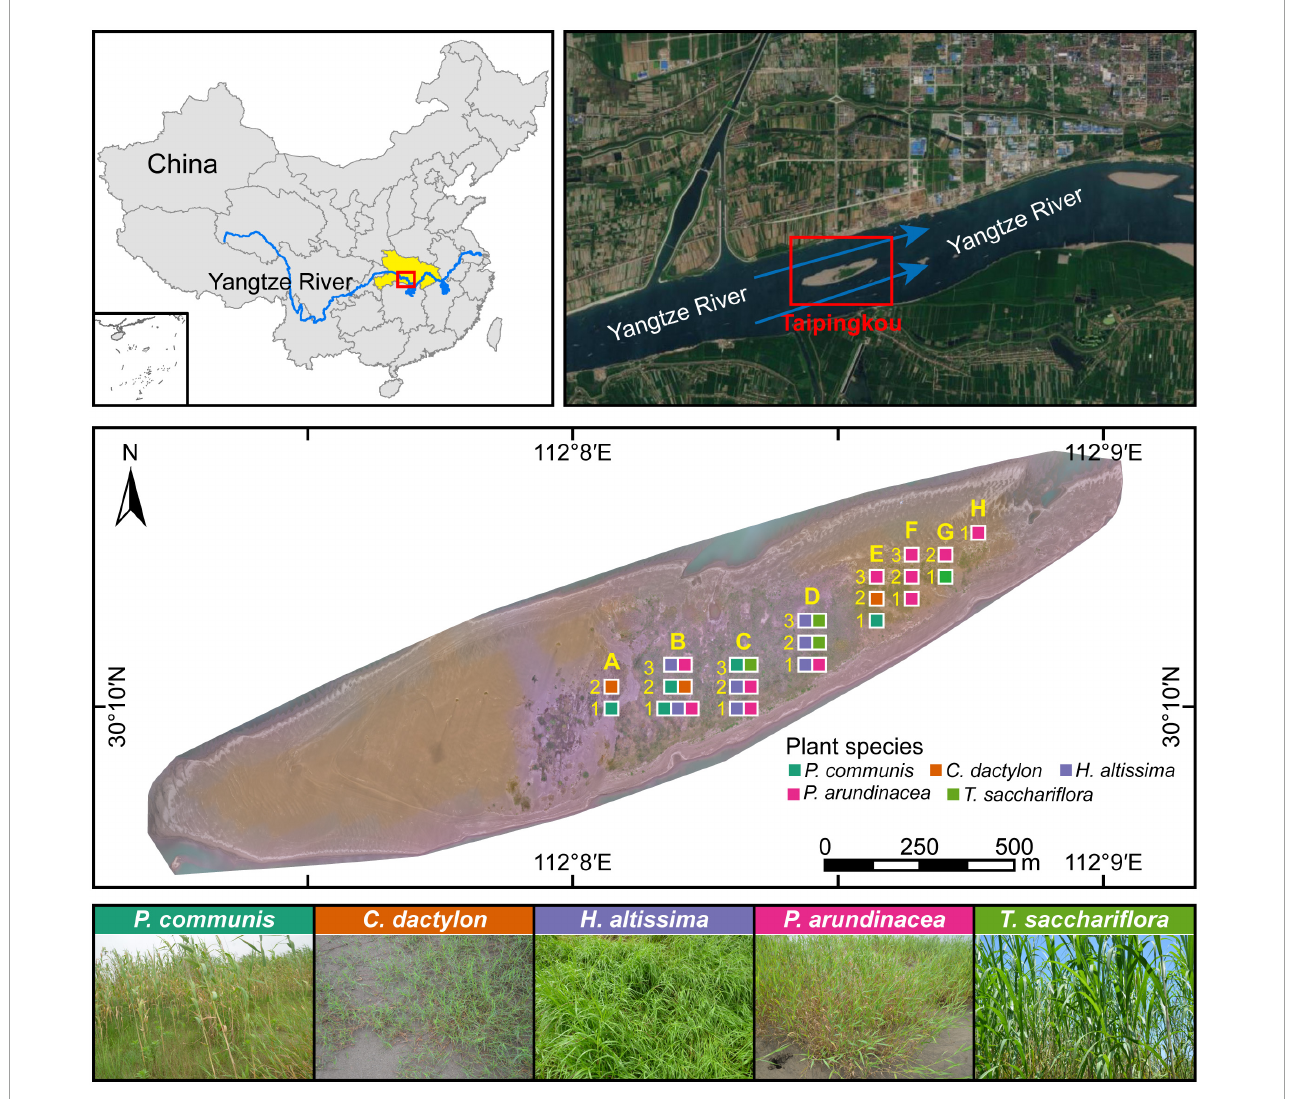
FIGURE1 Location of the study site, Taipingkou mid-channel bar, in the upper Jingjiang section of the Yangtze River. Blue arrows indicate the flow direction of the Yangtze River. Yellow capital letters and numbers indicate the positions of the sampling quadrats in the transverse and longitudinal directions, respectively. Squares with different color represent the type of dominant plant species exists in each